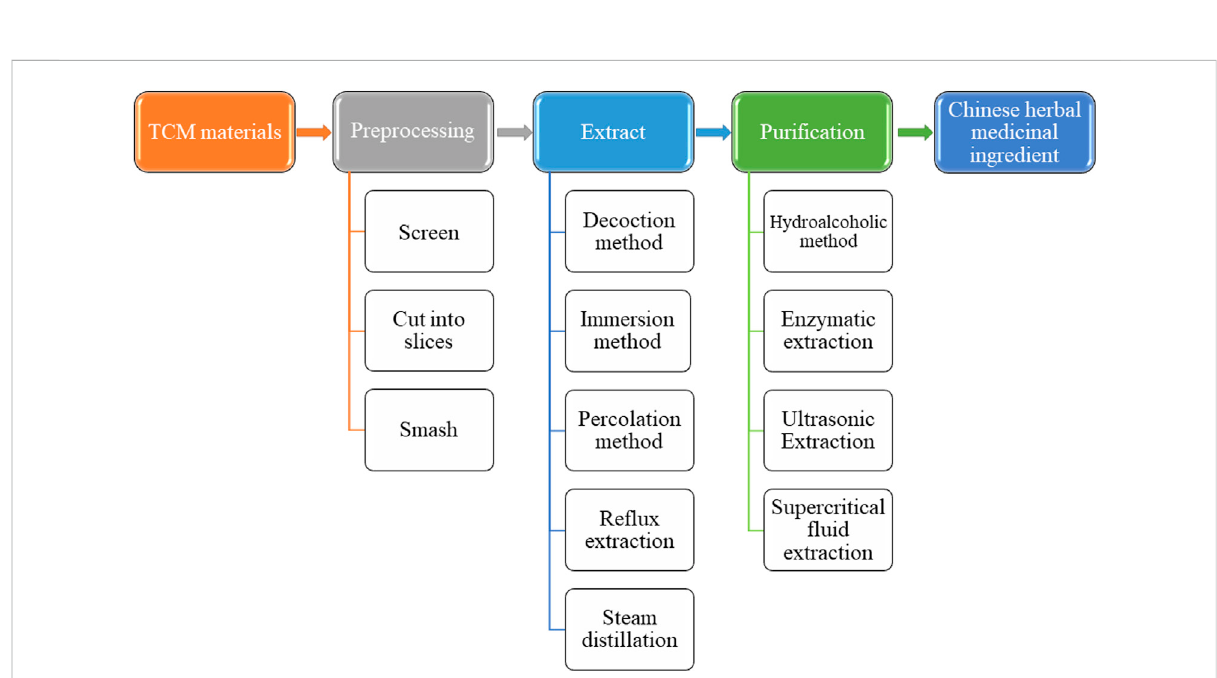
FIGURE 4 Preparation of TCM